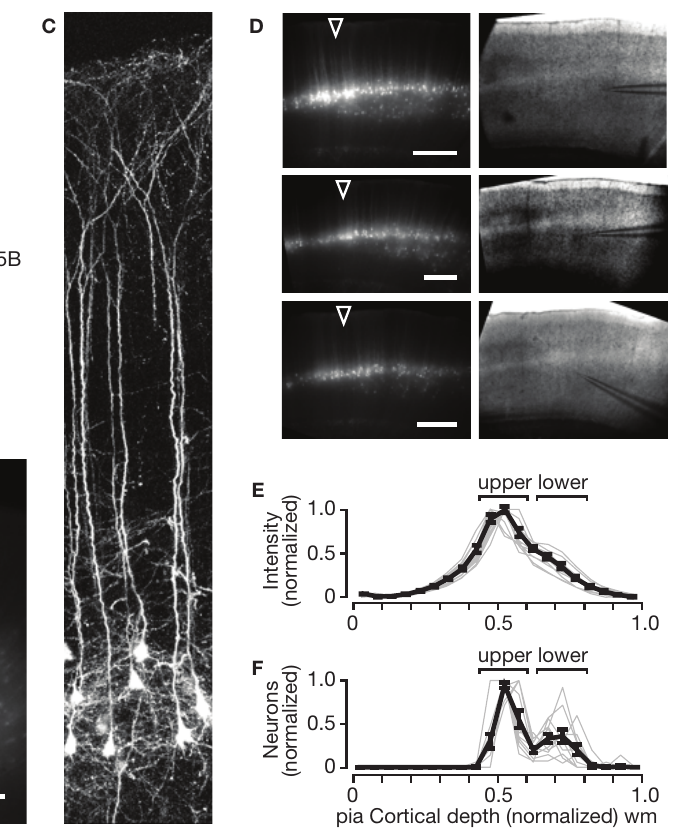
FIGURE 1 | Bimodal laminar distribution of YFP-positive neurons in motor- frontal cortex. (A) Epifl uorescence image of an off-sagitally slice prepared from a YFP-H animal, showing characteristic double blade of YFP-positive neurons in motor-frontal cortex. The pia and border between cortex and white matter (wm) are indicated by dashed lines. Primary somatosensory cortex (S1 barrel cortex) is to the left, with layer 4 barrels outlined (dashed lines). Motor-frontal cortex is to the right, and the frontoparietal border is indicated by the arrowhead ( ). Scale bar is 0.5 mm (also for other panels). Note greater radial extent of labeled neurons in layer 5B (L5B) of motor-frontal compared to somatosensory areas. (B) High-magnifi cation view from another slice, showing the radially bimodal distribution of YFP-positive neurons in upper and lower blades in motor-frontal